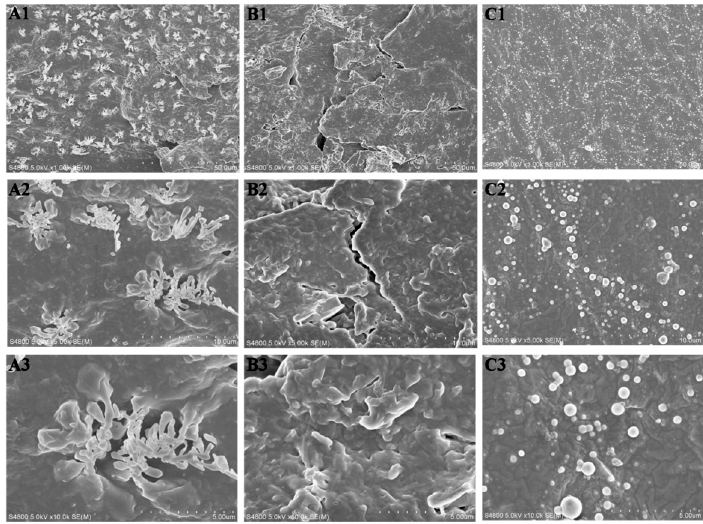
Figure 10. The SEM of the surface ofLPH-8 film after 49 days in vitro degradation ( A ) in pH of 11PBS solution; ( B ) in pH of 7.4 PBS solution;( C ) in pH of 11 PBS solution.( A1,B1,C1 ) magnified 1.0k; ( A2,B2,C2 ) magnified 5.0k; ( A3,B3,C3 ) magnified 10.0k.